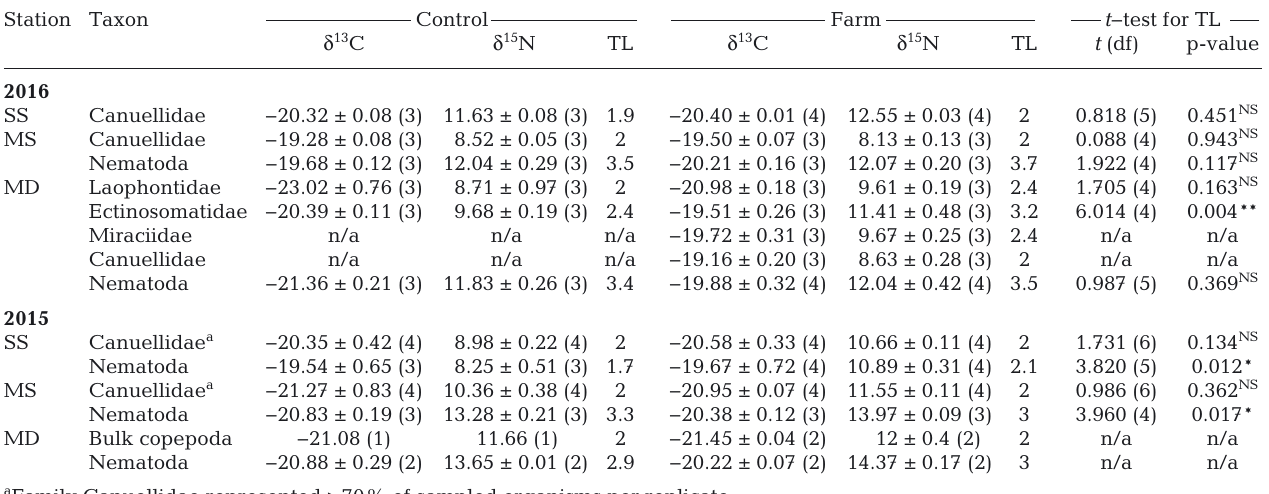
Table 1. δ 13 C and δ 15 N values (mean ± SD, with number of replicates shown in parentheses) and trophic levels (TL, mean) of harpacticoid copepods and nematodes from scallop farms in Laizhou Bay, China in 2015 and 2016. Samples were taken from ‘control’ and ‘farm’ sites at 3 stations, characterized by sediment type as sandy-shallow (SS), muddy-shallow (MS) and muddy-deep (MD). Results of t -tests of